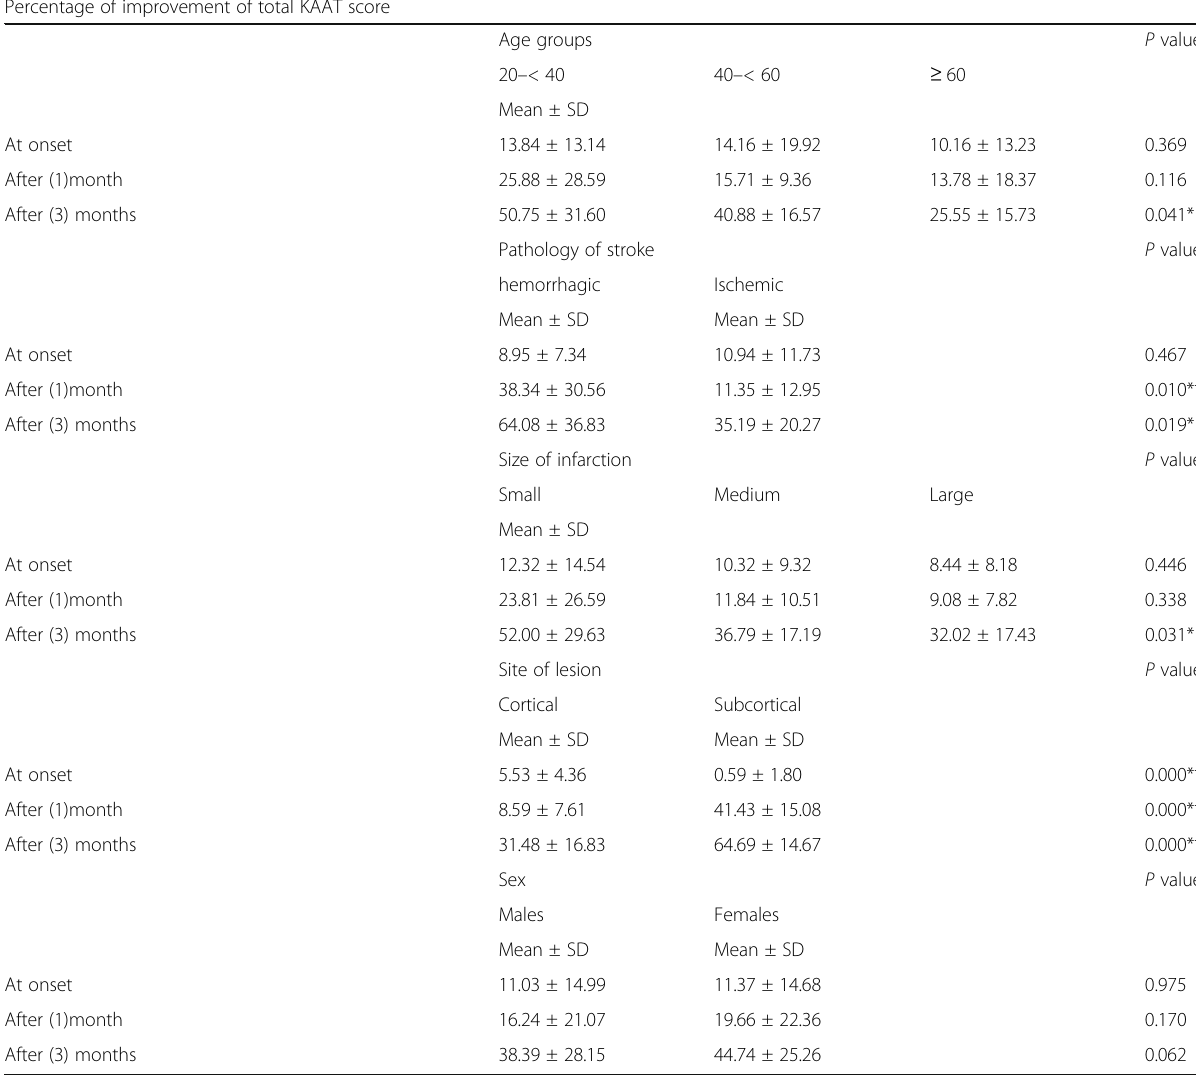
Table 5 Comparing demographic, clinical, and neuroimaging data regarding rate of aphasia recovery Percentage of improvement of total KAAT